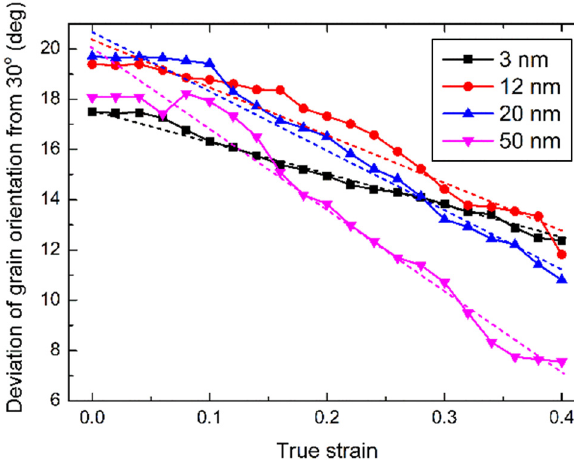
Figure 10: Variation of the deviation of the grain orientation from 30° versus the